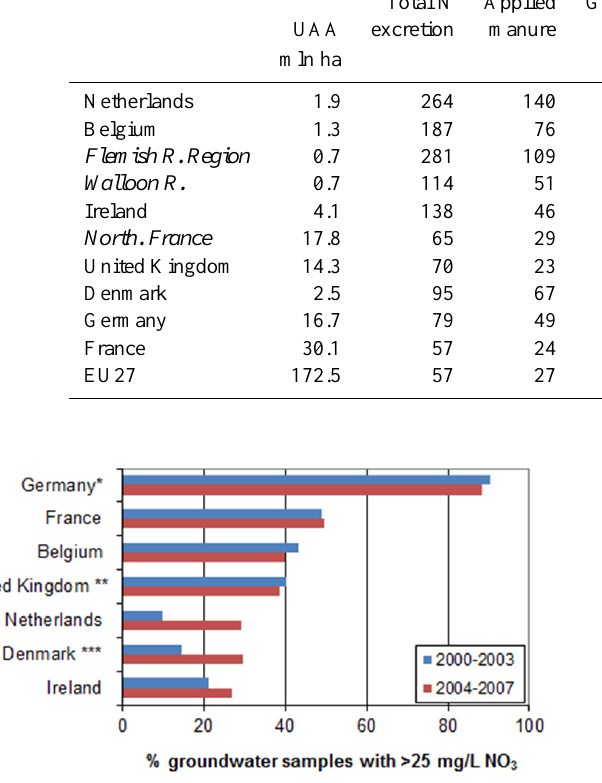
Fig. 3. Percentage of groundwater samples in monitoring programs Figure 3. Percentage of groundwater samples in monitoring programs for the Nitrates 2 for the Nitrates Directive exceeding 25 mgNO 3 L − 1 for the 2nd and 3rd reporting period (European Commission, 2011). * For Ger- Directive exceeding 25 mg NO 3 /l for the 2 nd and 3 rd reporting period (European Commission, 3 many only data for the agriculture monitoring network ** For the 2011). 4 reporting period 2000–2003 United Kingdom reported only stations within England. *** For the reporting period 2000–2003 Denmark provided aggregated